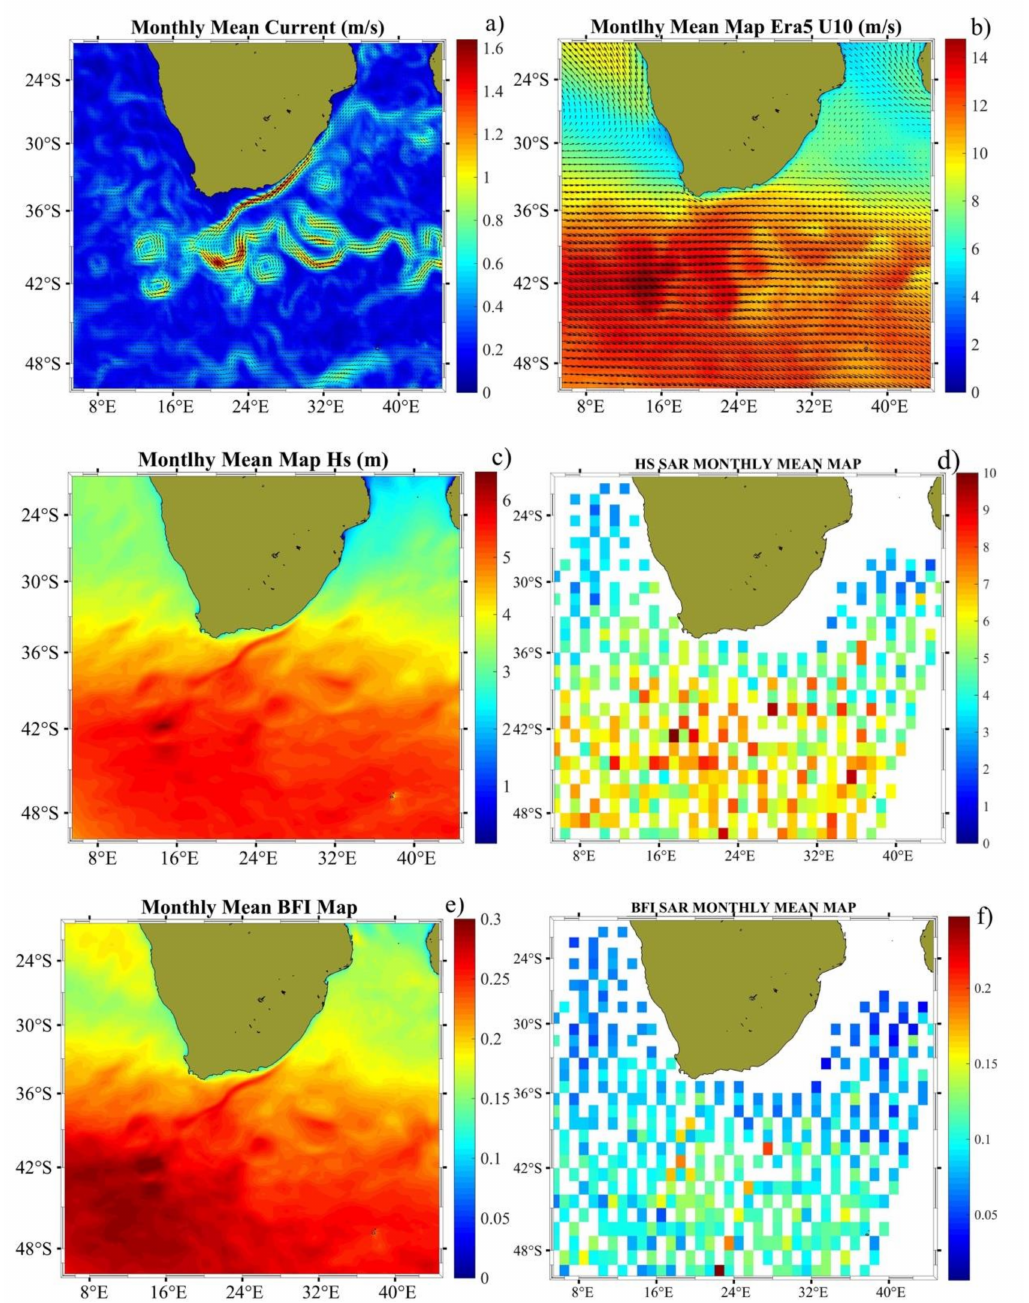
Figure 9. Monthly composite map of the ocean current ( a ), monthly mean wind ( b ), Modeled Hs monthly composite map ( c )(from the simulation considering currents) and SAR observations monthly mean of Hs ( d ), BFI composite map from the wave model ( e ) and the computed from SAR mean BFI ( f